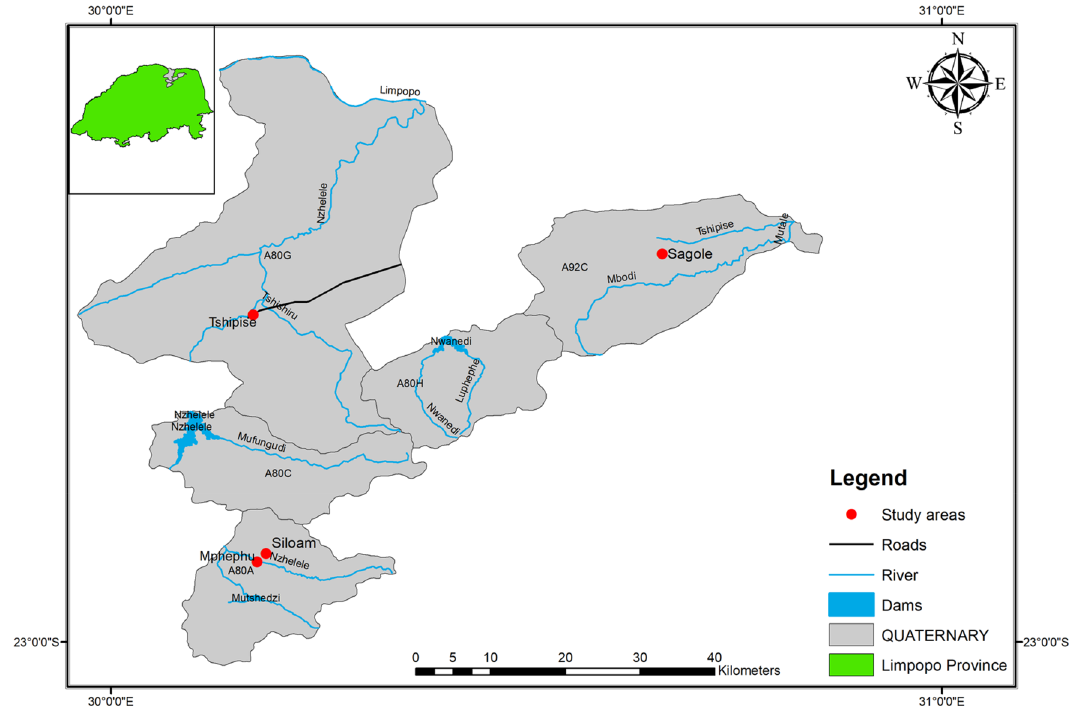
Figure 1. Map of the study area (Figure drawn using ArcGIS version 10.4, licensed to the University of Venda, South